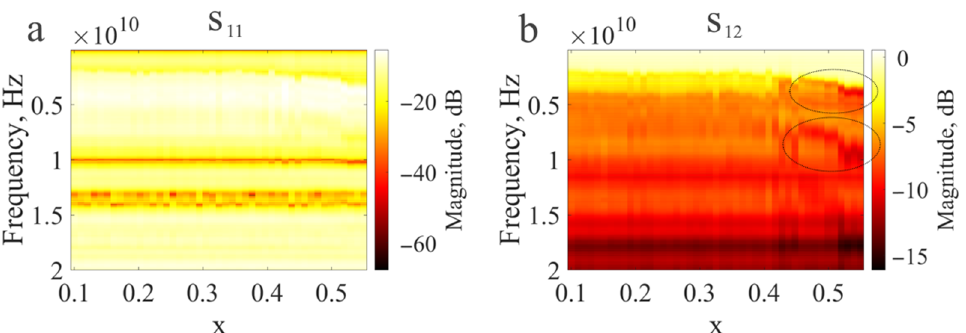
Figure 8. Dependence of the reflection coefficient (S 11 ) ( a ) and the transmission coefficient (S 12 ) ( b ) MSL with samples on the frequency and composition of the 4th section of the system. The molar concentration PT is plotted along the horizontal axis. The ellipses mark the resonance minima.